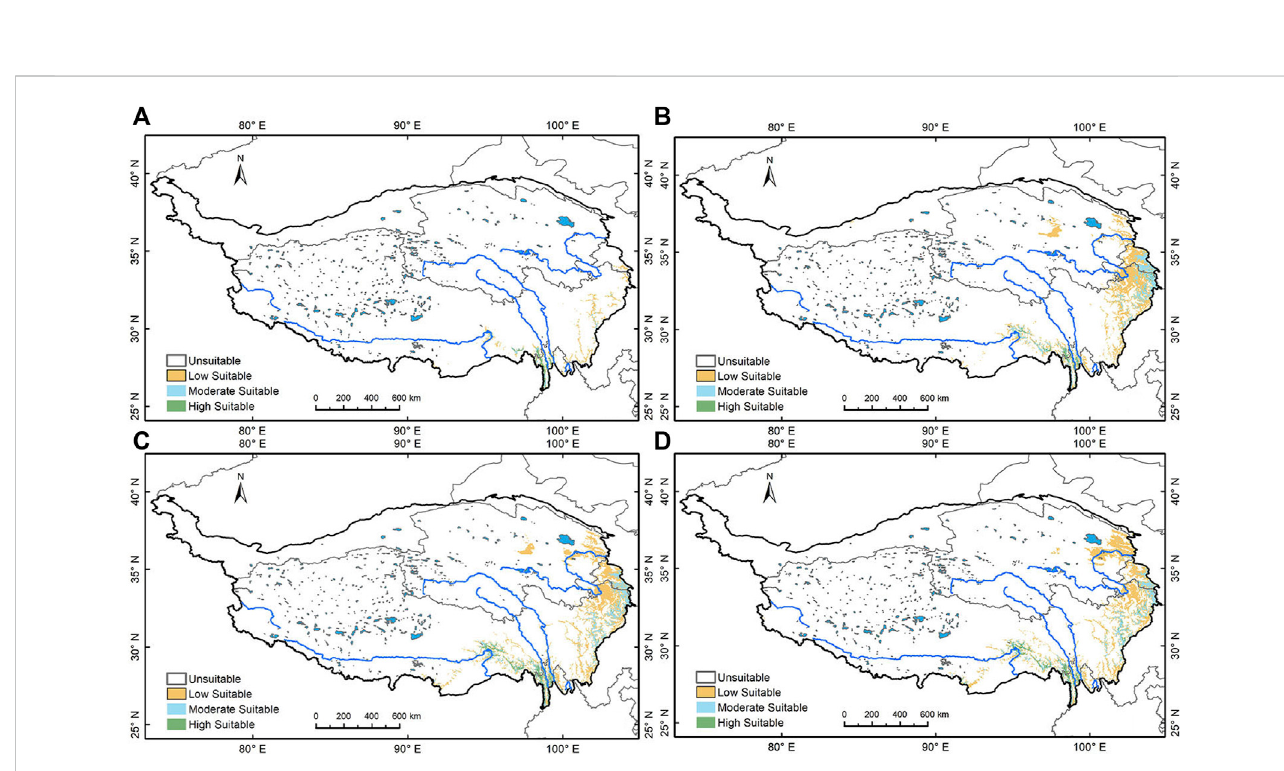
Simulation of Pinus ’ geographical distribution. (A) Pinus ’ geographical distribution area during the LGM; (B) during Early Holocene; (C) during the Mid Holocene; (D) during the Late